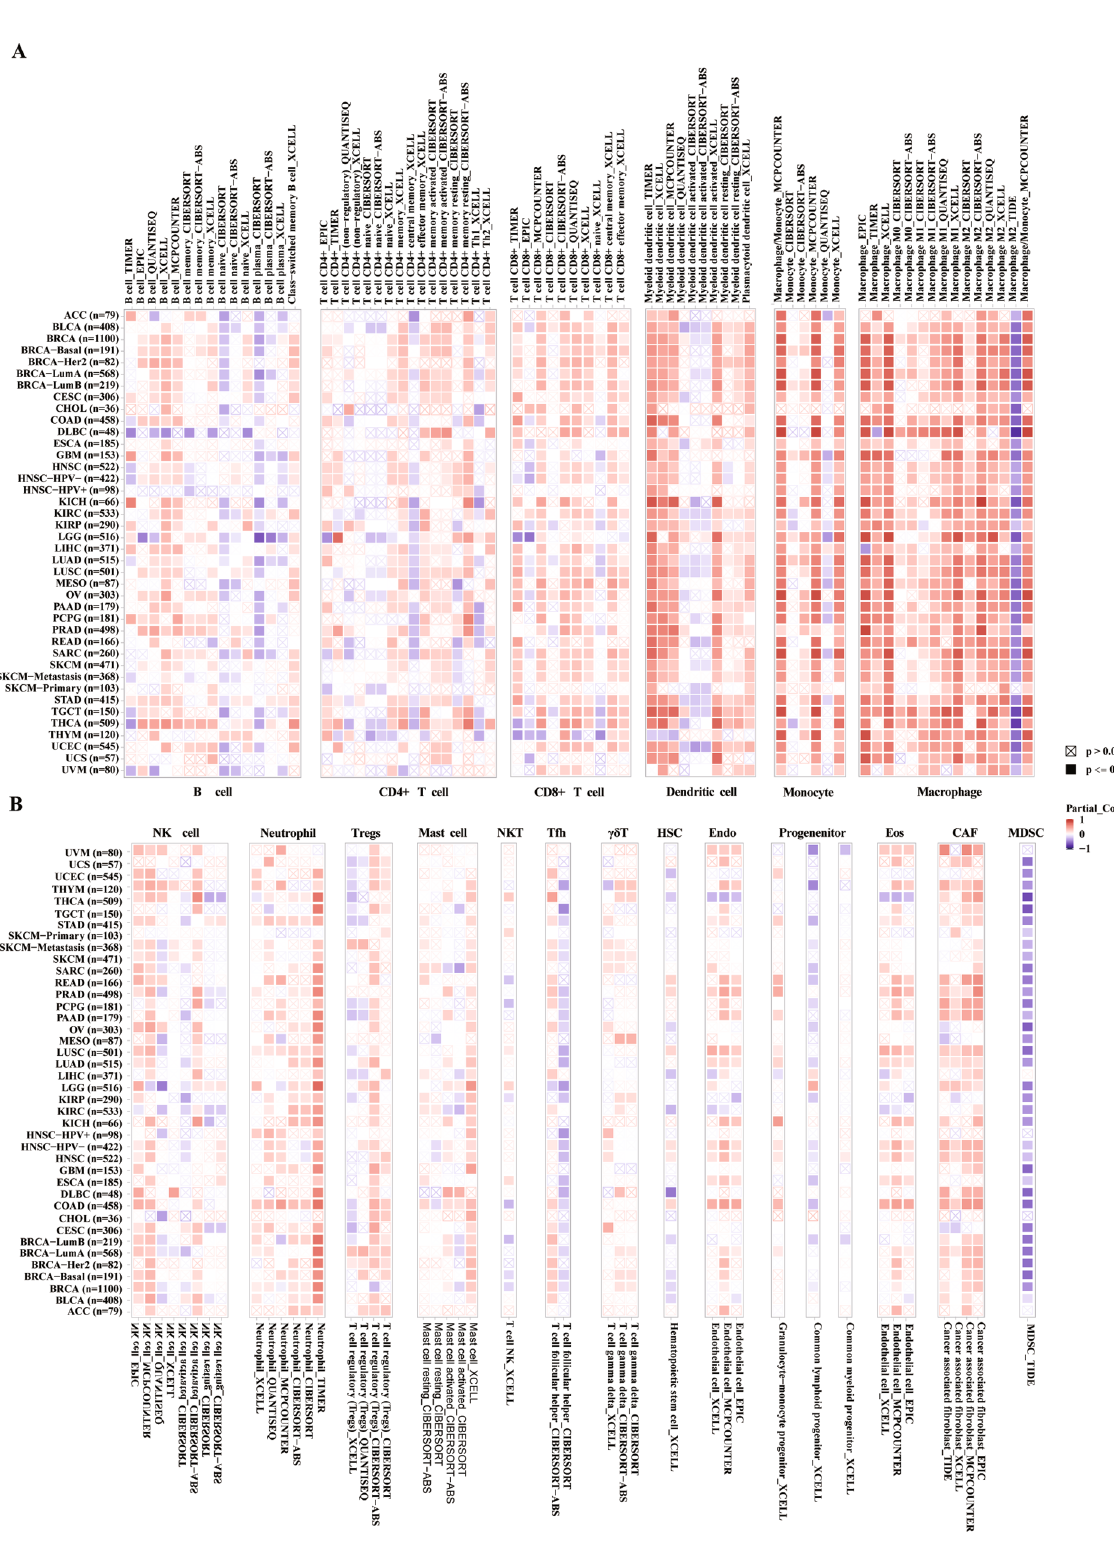
Figure 4. The relationship between CD68 and immune infiltrates based on the TIMER2.0 analysis in pan-cancer. The correlation between CD68 with B cell, CD4 + T cell, CD8 + T cell, dendritic cell, monocyte, macrophage in pan-cancer ( A ). The correlation between CD68 with NK cell, neutrophil, Tregs, mast cell, NKT, Tfh, γδT, HSC, Endo, progenitor, Eos, CAF, and MDSC in pan-cancer ( B